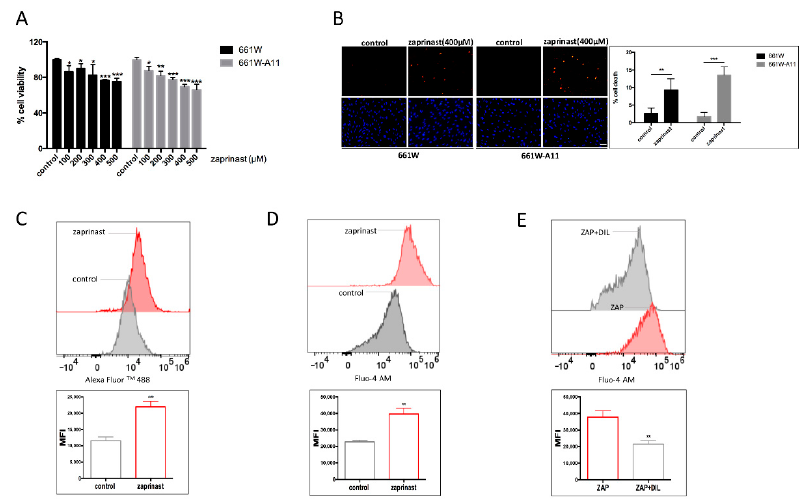
Figure 3. Effect of PDE6B inhibition by zaprinast treatment. ( A ) Cell viability assay, based on MTT, after treatment with scaling concentrations of zaprinast on 661W and 661W-A11 cells. Values of cells treated with the vehicle (0 μ M, control) were set as 100% cell viability. ( B ) TUNEL assay detected dying cells (upper panels, red) in zaprinast-treated 661W and 661W-A11 cells; nuclei were stained with DAPI (lower panels, blue). Control shows cells treated with the vehicle (DMSO). Scale bar: 40 μ m. On the right-hand side, quantifications of the TUNEL + cells are reported. ( C ) Increased cGMP levels were detected by flow cytometry using an antibody (anti-cGMP) and a secondary antibody labeled with Alexa Fluor 488 in zaprinast-treated versus untreated 661W-A11 cells. Control: cells treated with the vehicle (DMSO); zaprinast: cells treated with 400 μ M zaprinast for 24 h. ( D ) Increased Ca 2+ levels were detected by flow cytometry staining with Fluo-4 AM in zaprinast-treated versus untreated 661W-A11 cells. Control: cells treated with the vehicle (DMSO); zaprinast: cells treated with 400 μ M zaprinast for 24 h. ( E ) Decreased Ca 2+ levels were detected by flow cytometry in zaprinast (+)- cis diltiazem-treated versus zaprinast-treated 661W-A11 cells. ZAP: cells treated with 400 μ M zaprinast for 24 h; ZAP+DIL: cells pretreated with 50 μ M (+)- cis diltiazem for 2 h and then treated with 400 μ M zaprinast and 50 μ M (+)- cis diltiazem for 24 h; MFI: mean fluorescence intensity. Statistical comparison: Student’s unpaired two-tailed t -test; * p < 0.05, ** p < 0.01, *** p < 0.001.